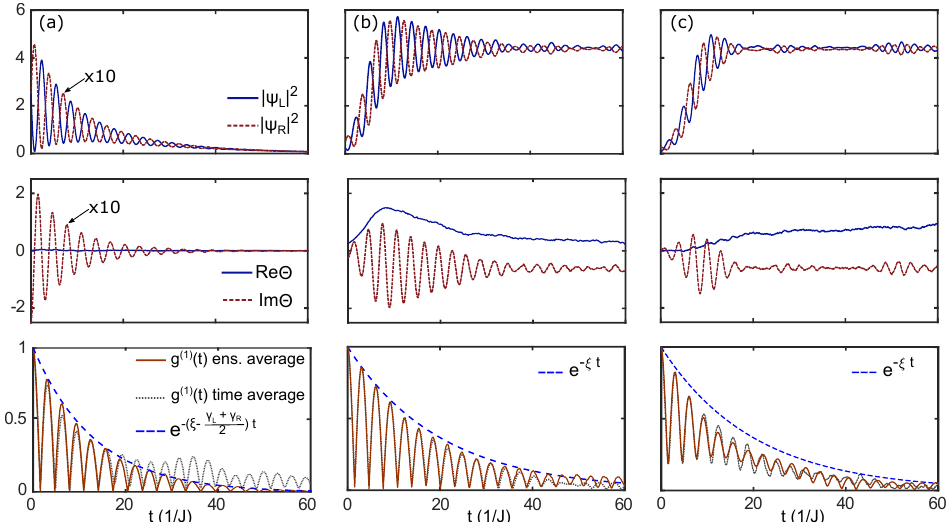
Figure 3. Dynamics of the polariton populations | ψ L , R | 2 (upper panels), the coherence Θ (middle panels), and the left-well polariton field correlation function g ( 1 ) ( t ) (lower panels), for the same parameters as in Figure 2 with the addition of phase fluctuations causing decoherence with rate ξ = 0.05 J , as obtained from the ensemble averaged solution of Equations (1) and (2). ( a ) Linear case ( η = 0) with the below threshold pumping P L = 1000 J and P R = 990 J leading to the exponential decay in the correlation function g ( 1 ) ( t ) ∝ e − ( ξ −| γ L + γ R | /2 ) t . ( b ) Same as in ( a ), but for stronger pumping above threshold P L = 1080 and P R = 1020; independently of the initial value of Re Θ ( 0 ) , the phase fluctuations cause an exponential decay in g ( 1 ) ( t ) ∝ e − ξ t while the system approaches the steady state. ( c ) Same as in ( b ) but in the presence of nonlinearity η = 0.1 J , causing a slightly accelerated decay of g ( 1 ) ( t ) ∝ e − ξ (cid:48) t with ξ (cid:48) > ξ , and faster approach of the system to the steady state. In the lower panels, we also show the correlation functions g ( 1 ) ( t ) obtained from the long-term average of the system dynamics (the oscillating tail of g ( 1 ) is due to the finite length of the time